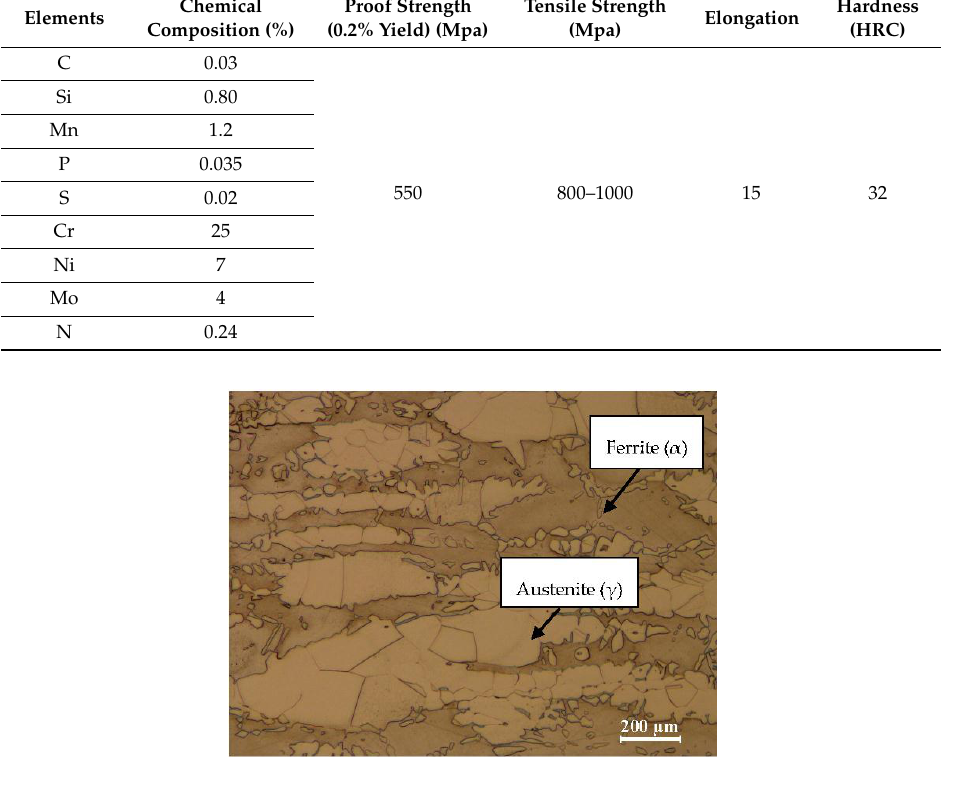
Figure 1. Microstructure of the SDSS UNS S32750 at 200× showing the distribution of each phase (Ferrite is continuous phase at 36% while Austenite is second phase at 64%).